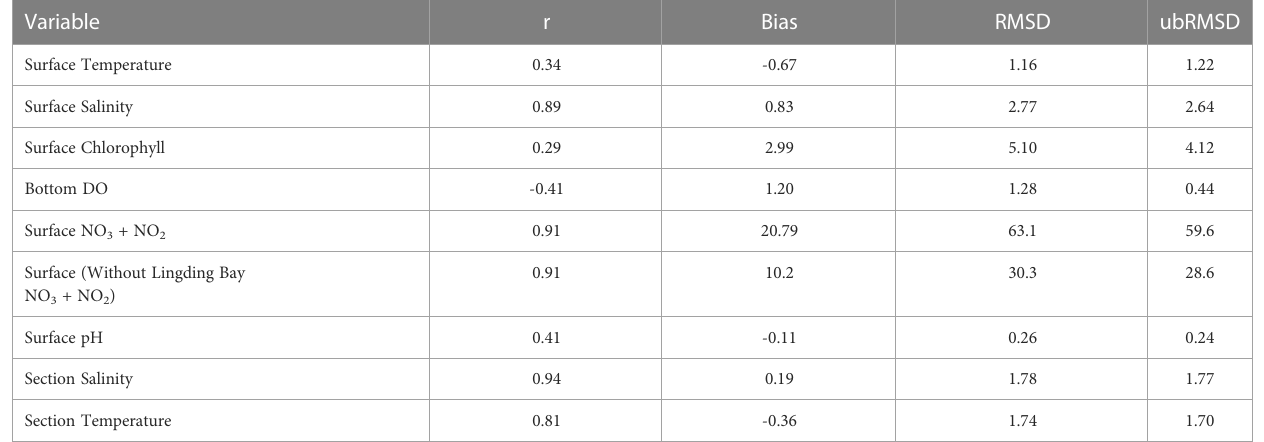
TABLE 3 Model evaluation statistics for 2015 – 2018.